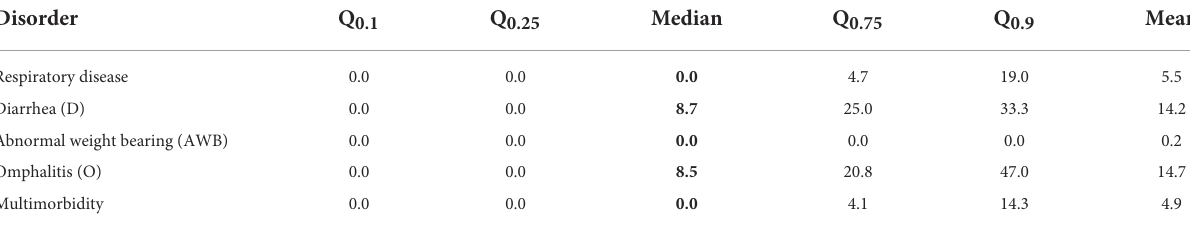
TABLE 9 Herd prevalence of disorders on herd level on 64 organic farms * .